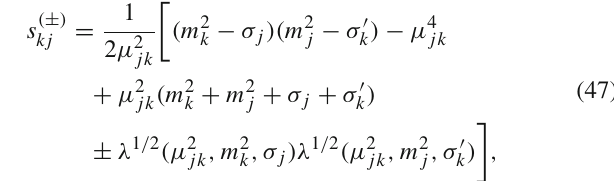
crosses the real s -axis. The s the upper-half plane.